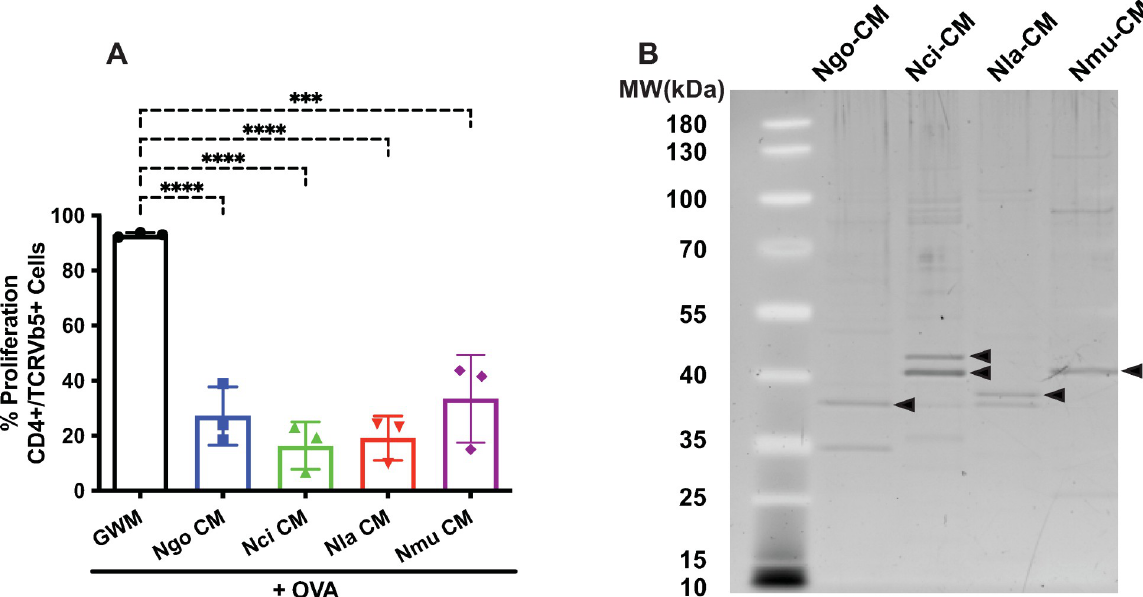
Fig 3. Conditioned medium prepared from cultures of commensal Neisseria species inhibits OVA-primed DC-induced T cell proliferation. Aliquots of conditioned medium (CM) of the different bacteria ( Ngo -CM, Nci -CM, Nla -CM, or Nmu -CM) prepared from cultures grown in Grave-Wade medium (GWM) containing equivalent numbers of particles ( Table 2 ) were added to DCs in the presence of OVA for 24 hours as indicated. DCs were then co-cultured with CFSE-loaded OT-II T cells for seven days. (A) Mean percentage of CD4+ T cell proliferation stimulated by dendritic cell presentation of GWM plus OVA (black), Ngo- CM plus OVA (blue), Nci- CM plus OVA (green), Nla -CM plus OVA (red), or Nmu- CM plus OVA (purple). Data were analyzed using one-way ANOVA with Dunnett’s multiple comparisons test ( * , P < 0.05; ** , P < 0.01; *** , P < 0.001; and **** , P < 0.0001). (B) Conditioned media prepared from liquid cultures of the 4 Neisseria species were loaded on SDS-PAGE gel with 1.5 x 10 6 particles per lane and stained and visualized by SYPRO Ruby. Bands marked with an arrow ( ➤ ) were identified by Mass Spectrometry as the PorB homolog of the species from which the CM was prepared. Both bands from Nci-CM were identified as PorB.